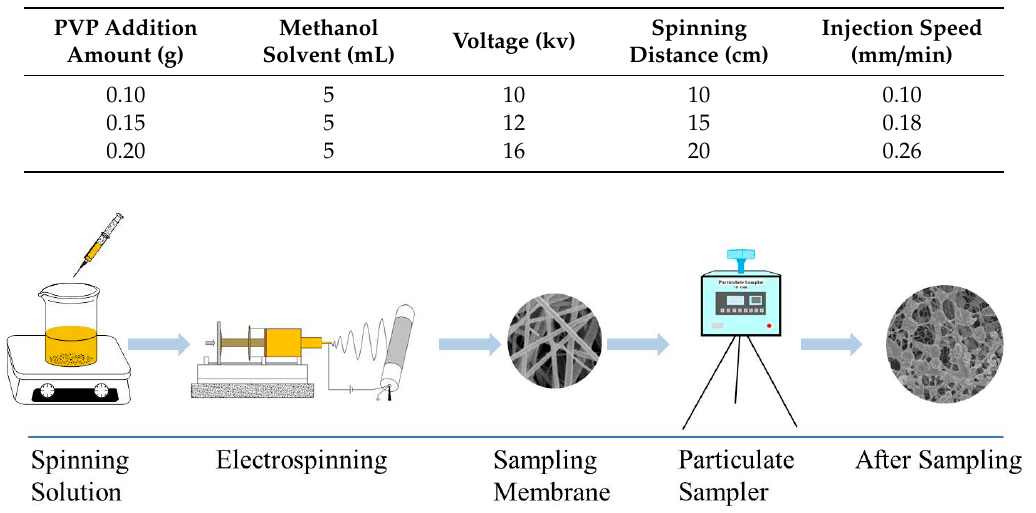
Table 11. Single factor spinning parameter design.